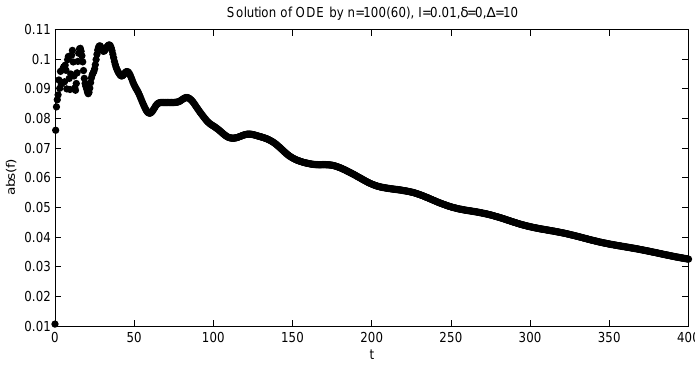
Figure 3. Eigenvalues α ( k ) of δ = 0 , I = 0 . 01 , ∆ = 10 , n = 100 for finite-difference scheme.